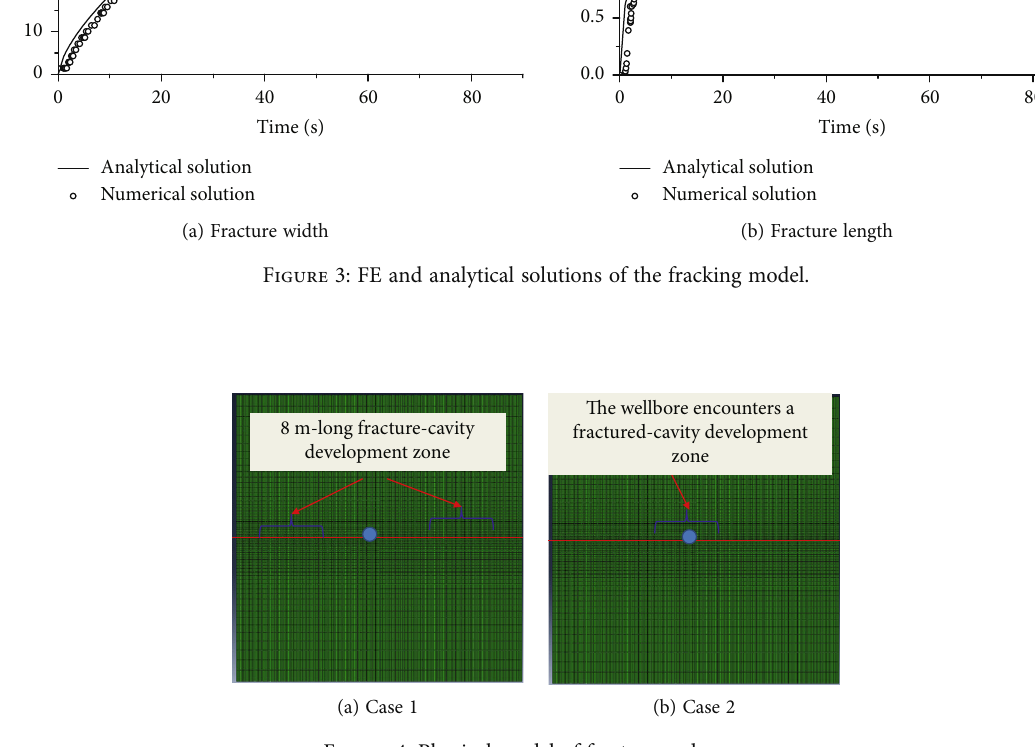
Figure 4: Physical model of fracture and